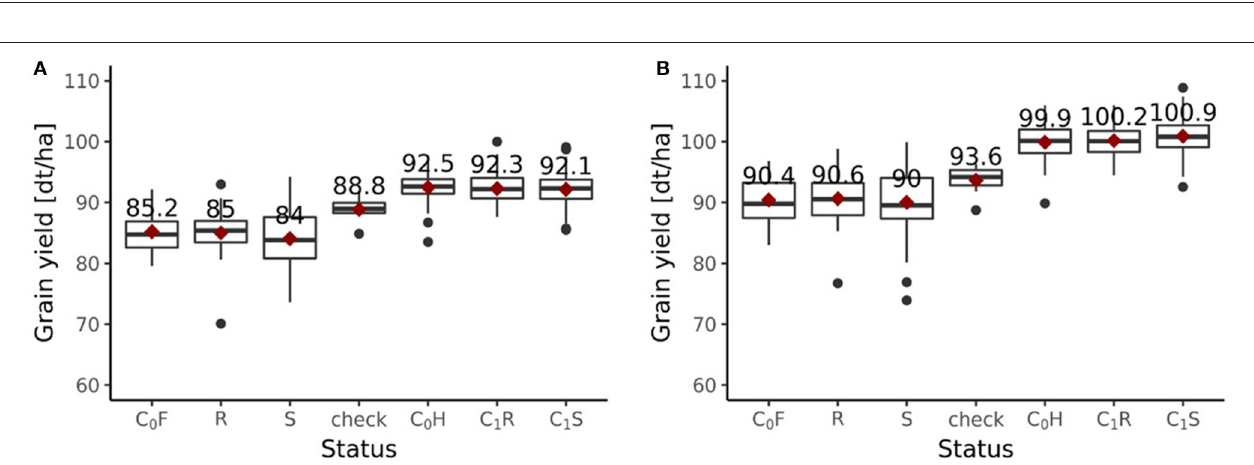
FIGURE 6 | Grain yield performance depending on the status of genotypes evaluated in the 2019 experiment. (A) Performances of the fractions from the breeding population with all six environments of 2018/2019 included. (B) Performances of the fractions from the breeding population with only 4 environments of 2018/2019 included. Status indicates the affiliation of each group of genotypes to a specific fraction within the breeding program. Female parent lines from the C 0 cycle are indicated as C 0 F, female parent lines from the randomly selected fraction of the C 1 cycle are indicated as R, female parent lines from the genomic-selected fraction of the C 1 cycle are indicated as S, checks are indicated as “check,” hybrids from the C 0 cycle are indicated as C 0 H, hybrids from the randomly selected fraction of the C 1 cycle are indicated as C 1 R, hybrids from the genomic-selected fraction of the C 1 cycle are indicated as C 1